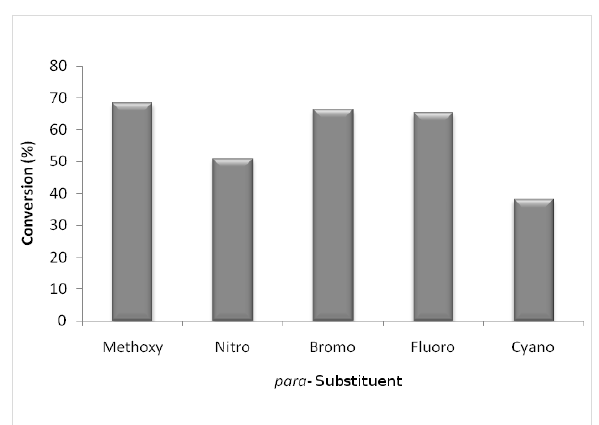
cases the hydrochloride salt of the base, formed as a byproduct in the reaction, remained in solution.